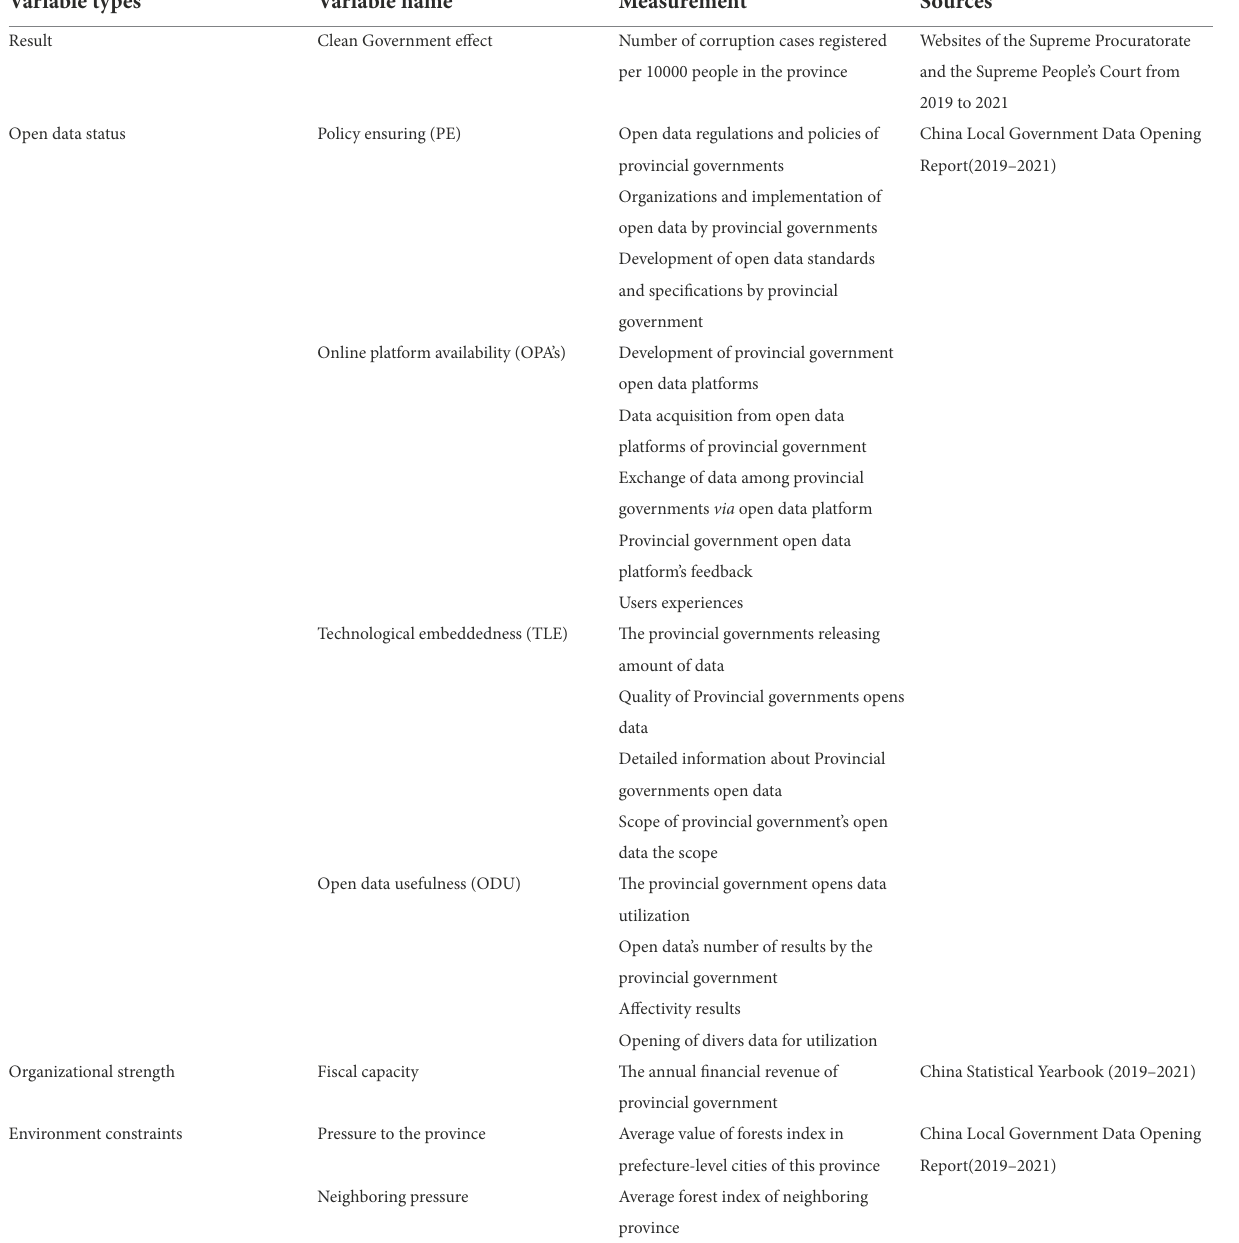
TABLE 3 Measurement indicators and data